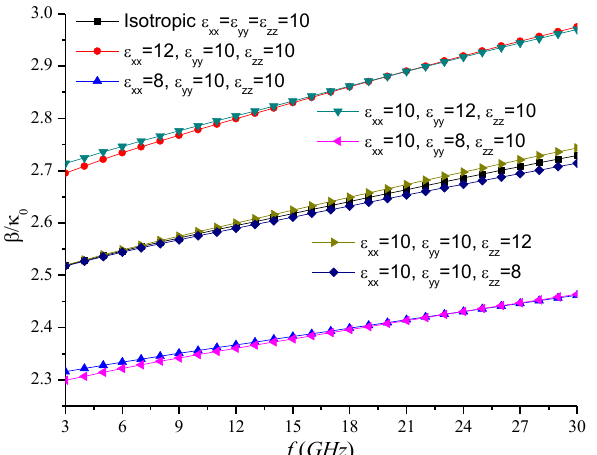
Figure 4.a: Effect of uniaxial anisotropy on the normalized phase constant